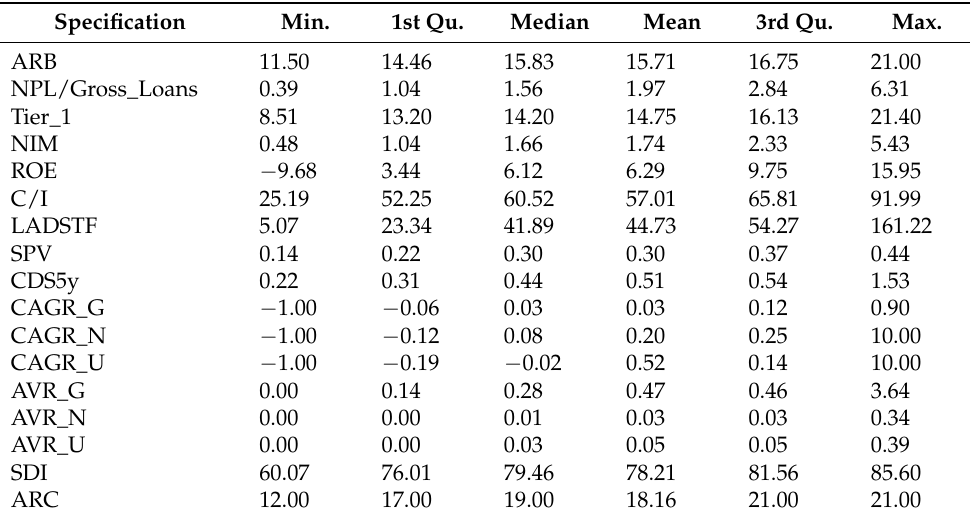
Table 3. Basic descriptive statistics for explanatory